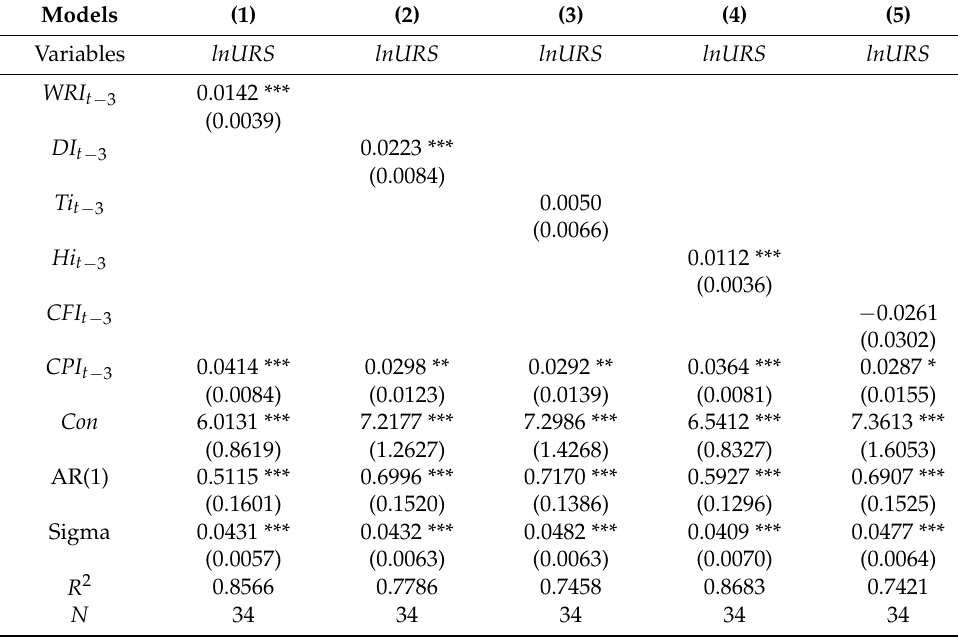
Table 4. Heterogeneous effects of different types of climate risks on residential